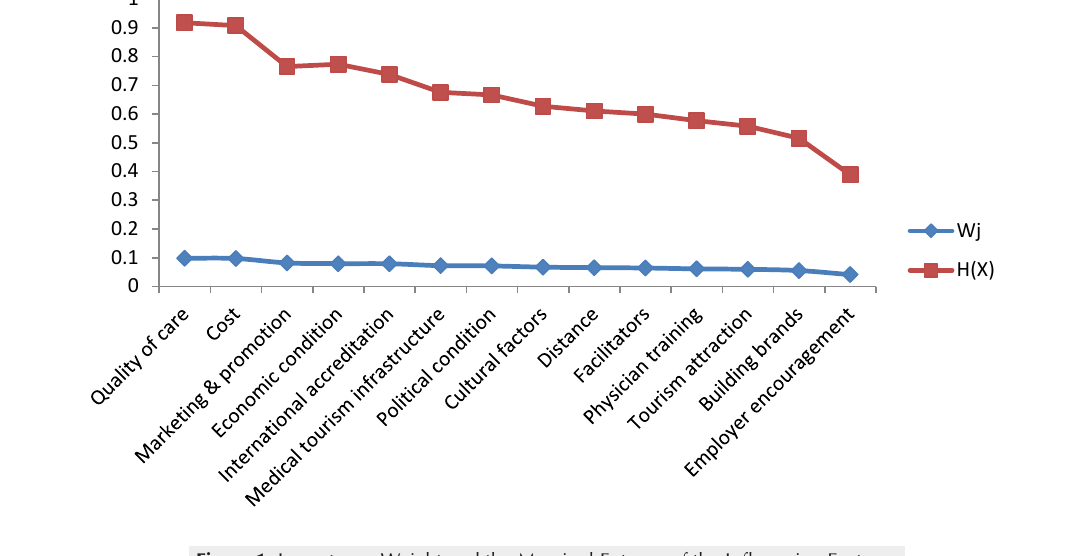
Figure 1. Importance Weight and the Marginal Entropy of the Influencing